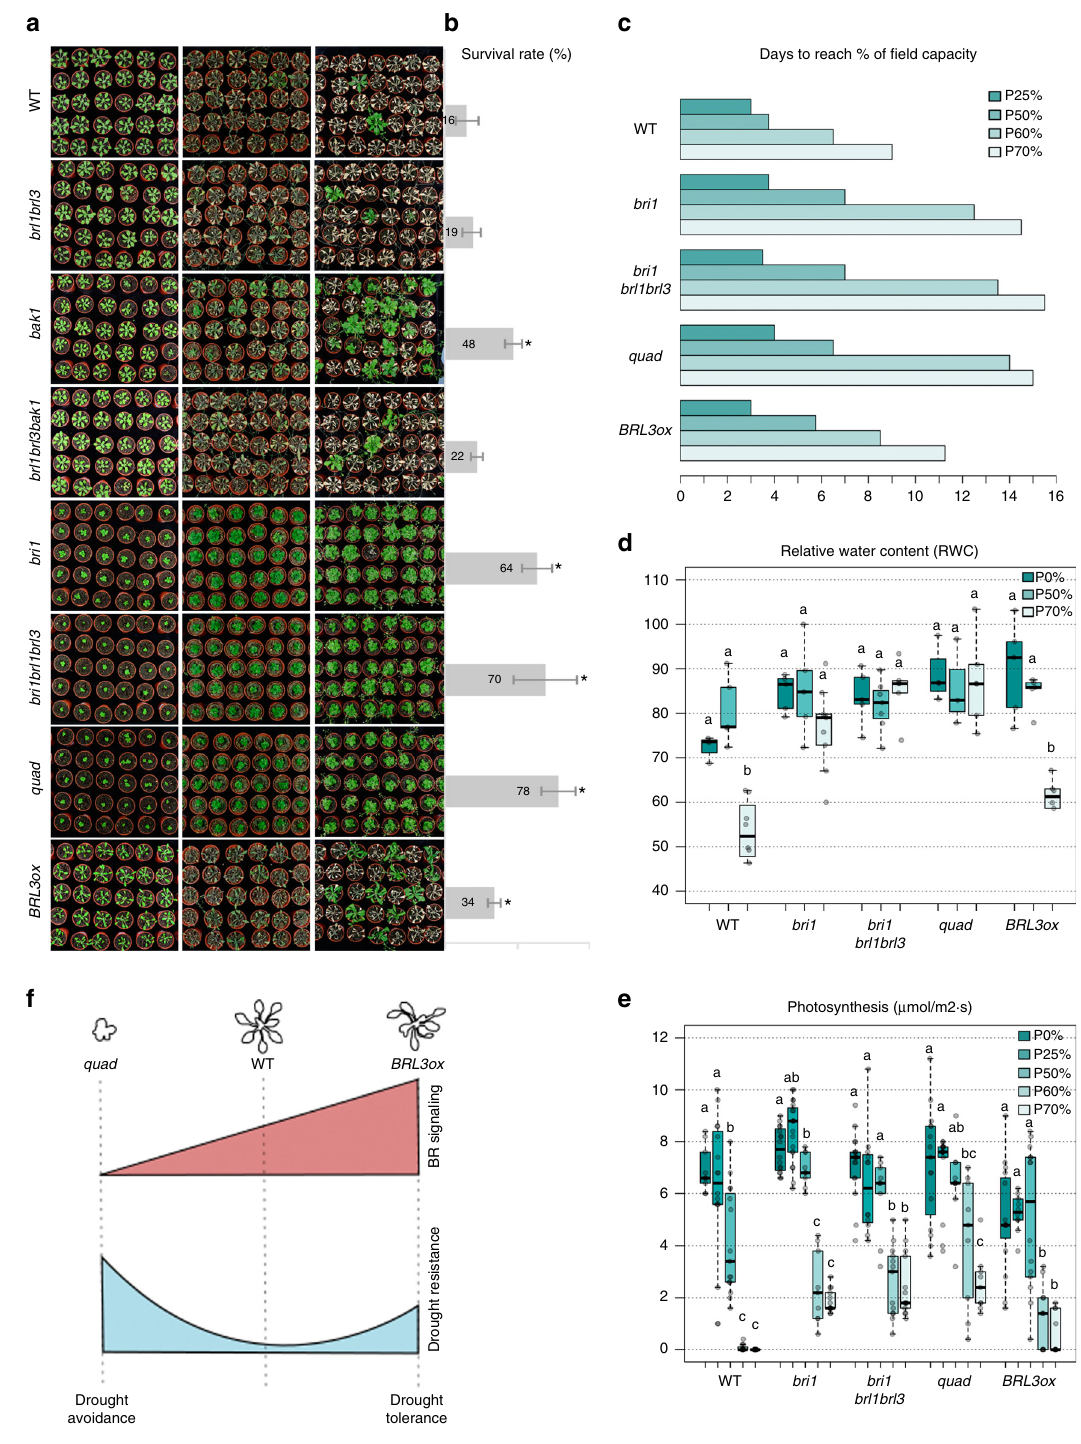
key role for BR receptors in promoting sugar metabolism,